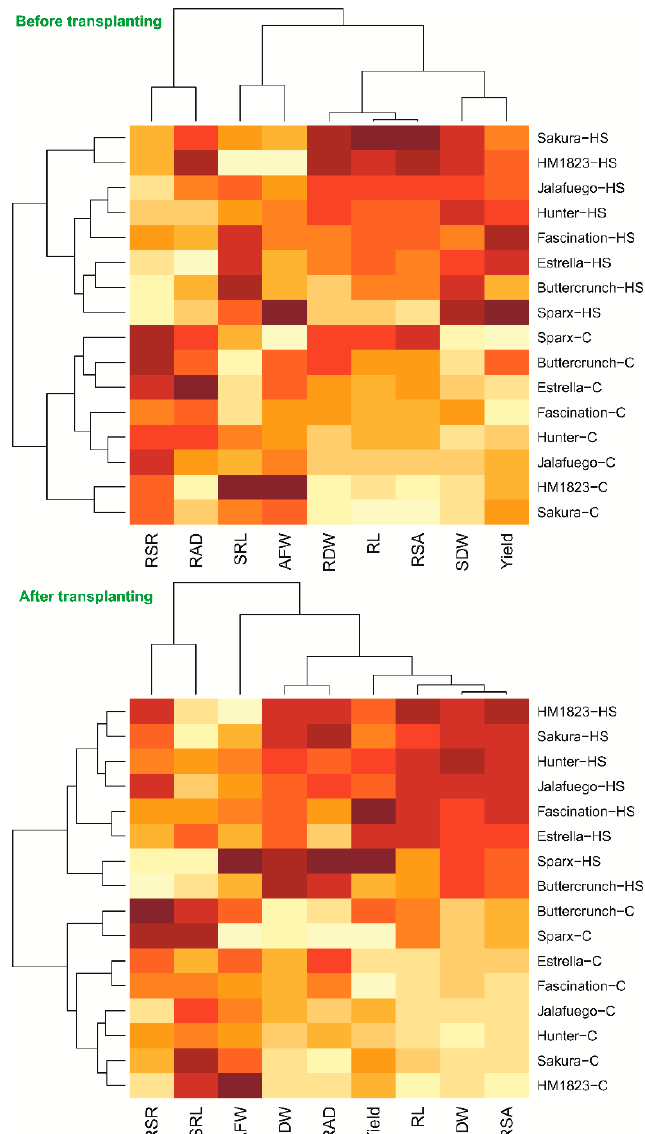
Figure 7. Heatmaps and clustering of the amendment treatments (C and HS) based on the (top) before-transplanting traits and (bottom) after-transplanting traits with the consideration of yield components. Each row represents a crop cultivar with or without HS treatment, and each column represents a measured variable, including shoot dry weight (SDW), root dry weight (RDW), root shoot ratio (RSR), root length (RL), specific root length (SRL), root average diameter (RAD), root surface area (RSA) and average fruit weight (AFW). The expression variable values of the heatmaps follow the red (high)–yellow (low) color scale. All data are standardized and measured variables are clustered based on their correlations.